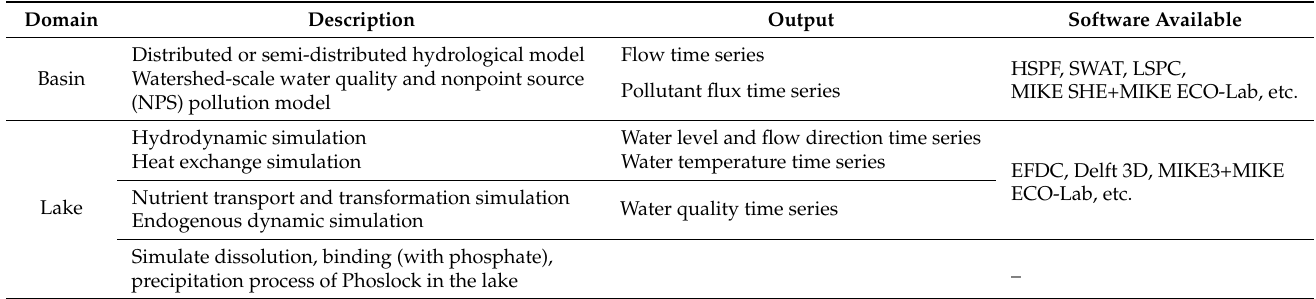
Figure 2. Structure of the modeling system for predicting effects of Phoslock application. Table 1. Models in the simulation system and available